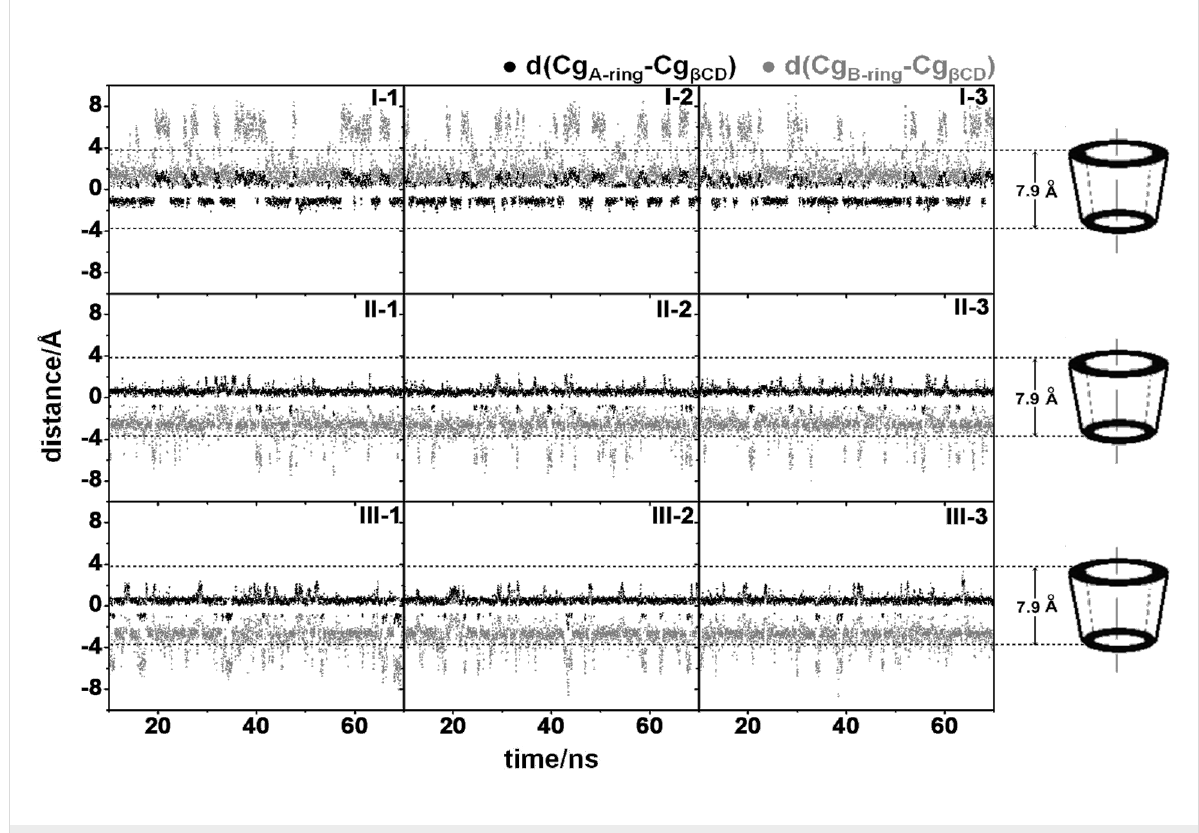
Figure 5: Distance between the centers of gravity of each fisetin ring (A/B) and β -CD along the simulation time for the three focused inclusion complexes I-III .